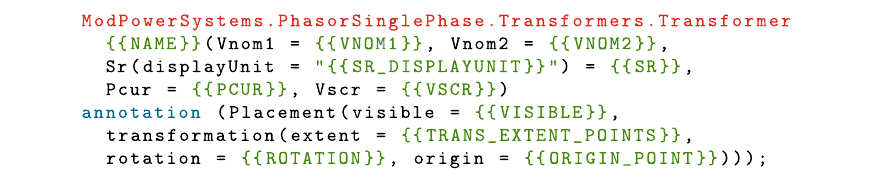
Fig. 8 Listing 4: Transformer subtemplate related to ModPowerSystems library